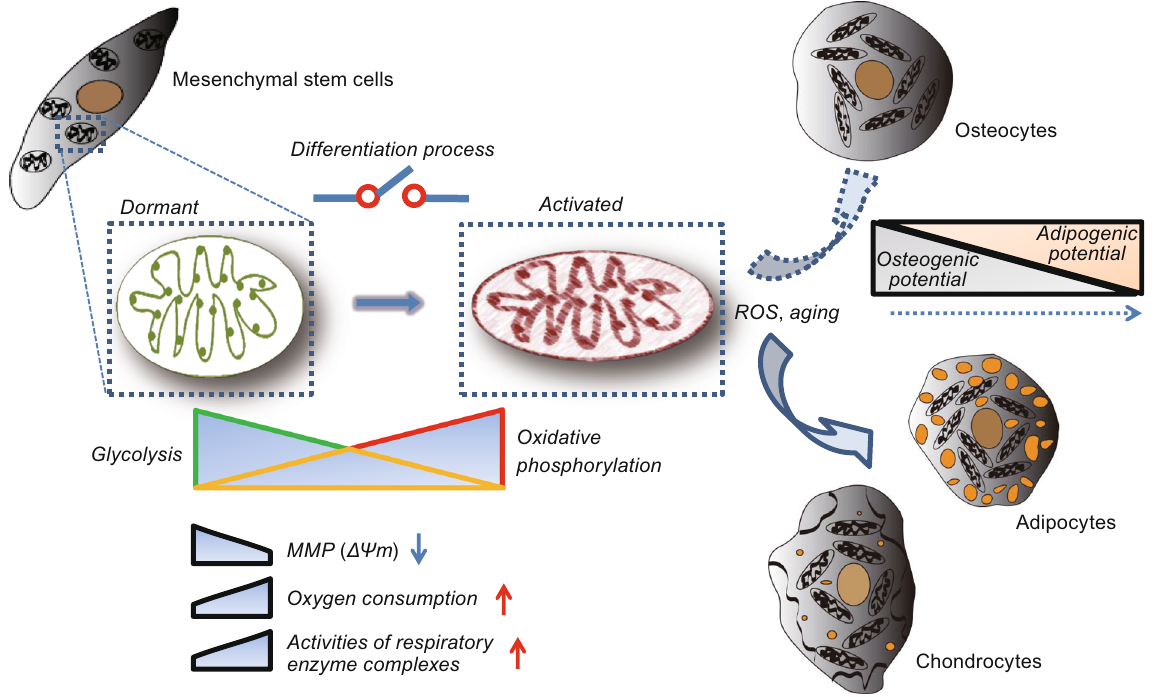
Figure 1. The regulation of mitochondria dynamics and function is essential for successful differentiation of MSCs. Mitochondria are mainly seen gathered around the nucleus in MSCs, whereas the mitochondria are more uniformly distributed in the cytoplasm of differentiated cells. Along with the process of differentiation, the morphology of mitochondria gradually becomes slender, and the number of mitochondria increases. The metabolic pattern has changed from glycolysis to oxidative phosphorylation; therefore, increased oxygen consumption and respiratory enzyme complex activation becomes logical. Notably, the membrane potential appears to be reduced in differentiated cells. The advancement of age and the high level of ROS can promote MSCs to adipocytes, whereas a low level of ROS can promote